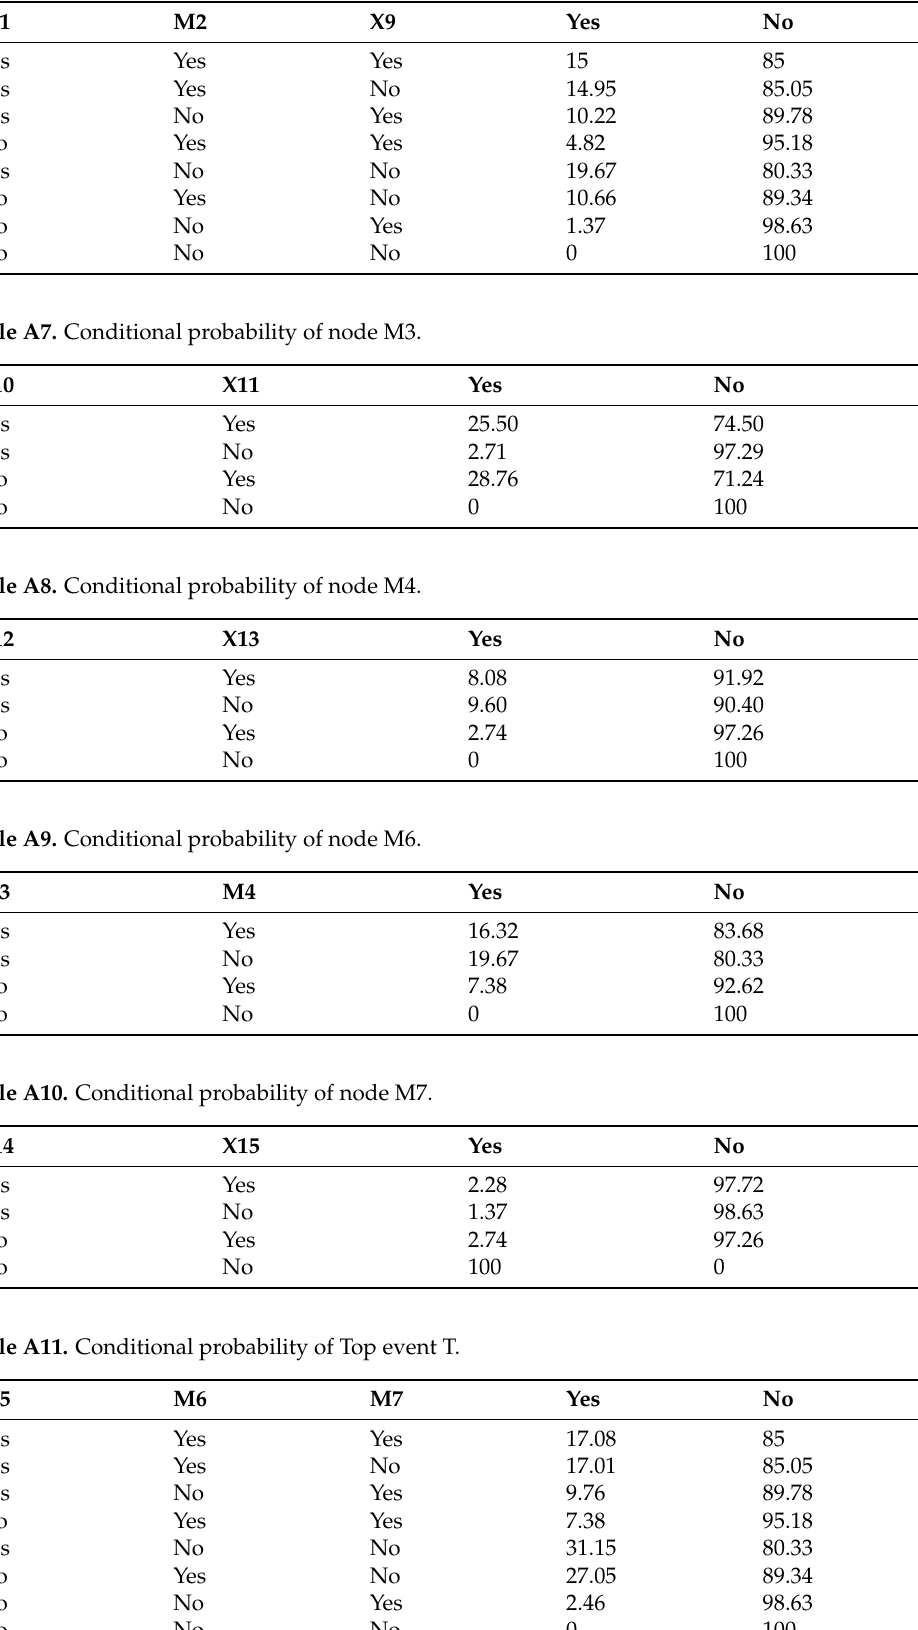
Table A6. Conditional probability of node M5.